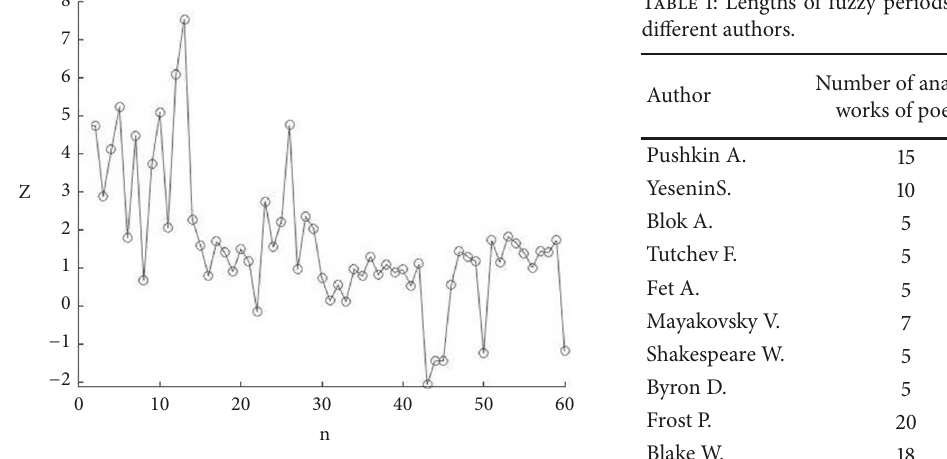
Figure 7: Graph Z (n) for the poem by Robert Frost “Fire and ice.”